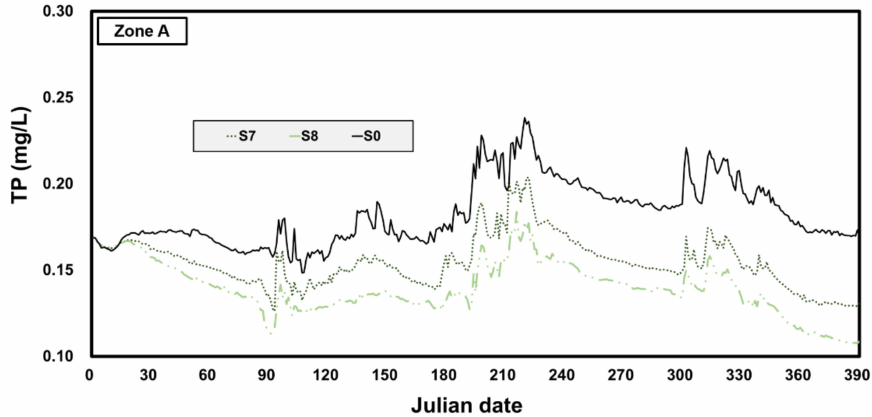
Figure 10. Simulated results of T-P concentration (Zone A, S0,